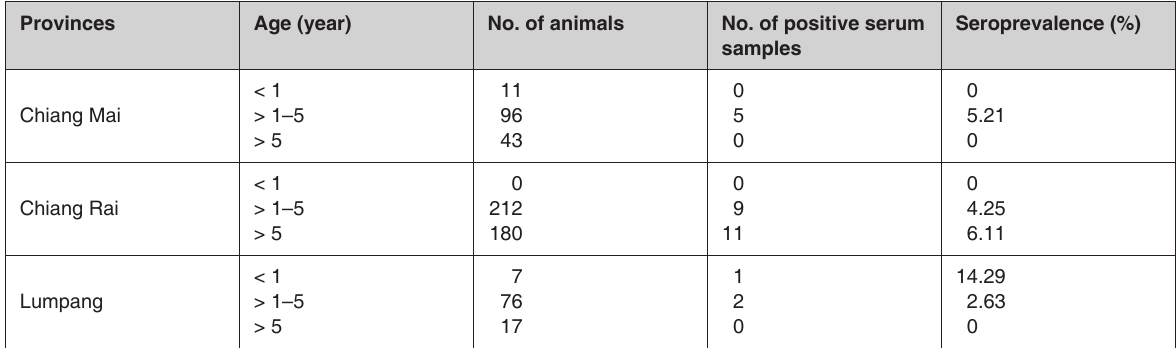
TABLE 2 Seroprevalence of C. parvum infection in different age groups of the dairy cows or heifers